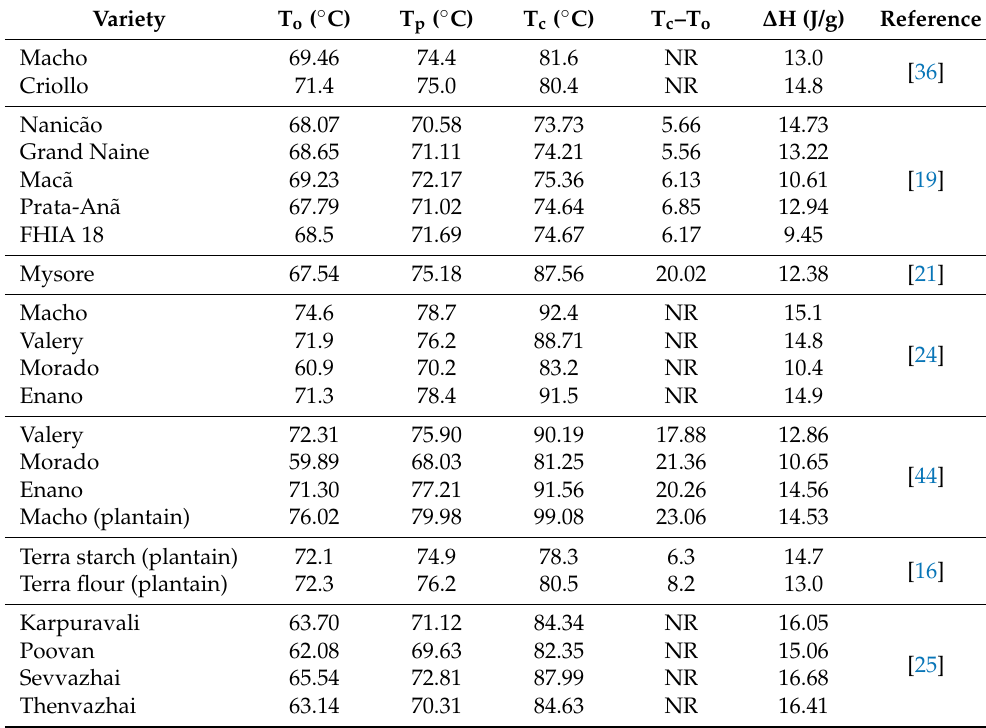
Table 4. Thermal properties of banana starch from various varieties.